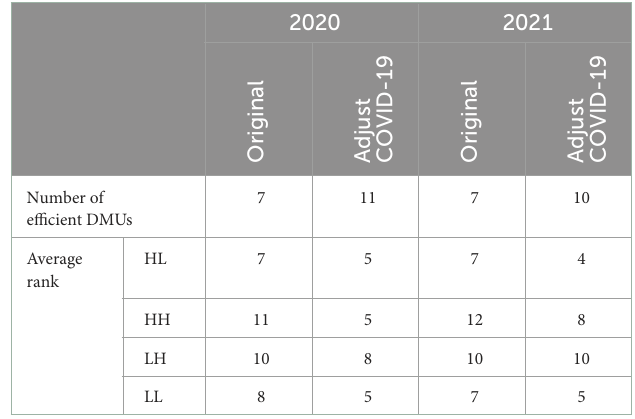
TABLE 10 Comparison of original efficiency and efficiency after environmental effect